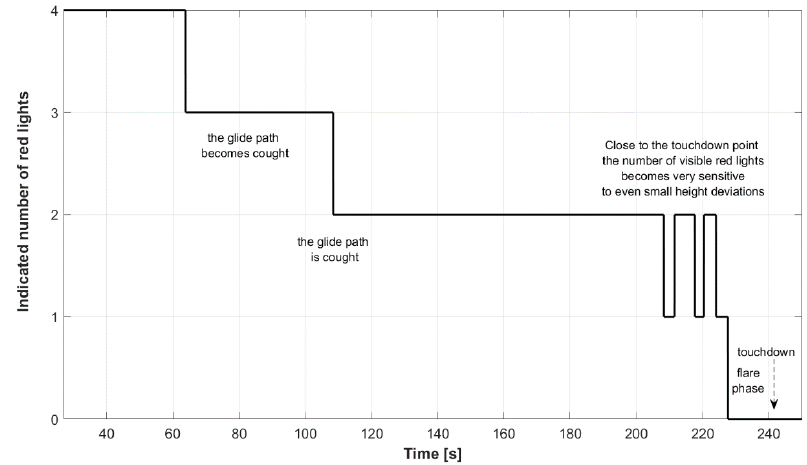
Figure 18. The vertical profile of the aircraft flight and sectors, related to specific PAPI light config- urations.